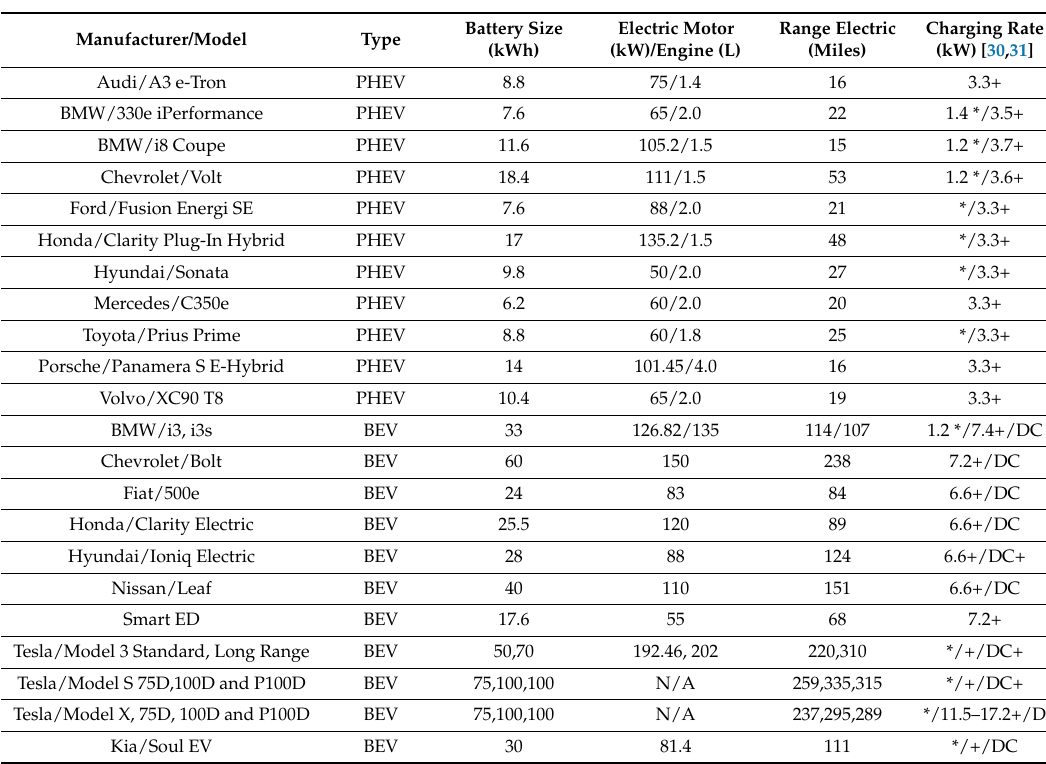
Table 3. Comparison of the PEV types and technologies